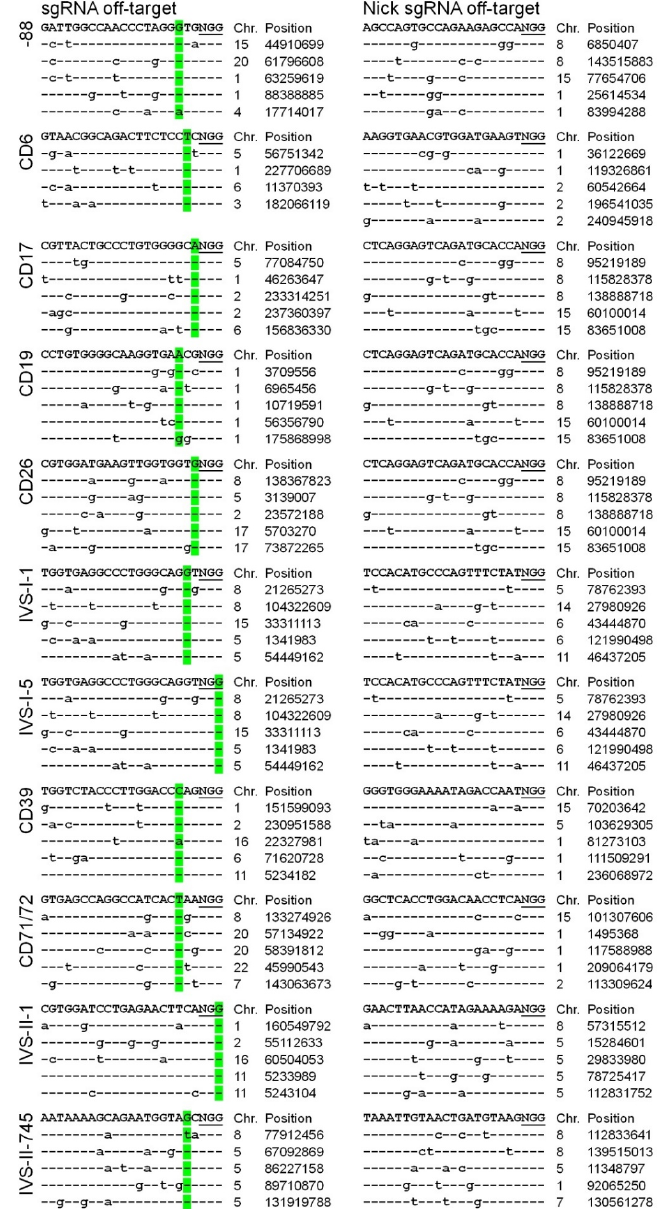
Figure 3. PE3 off-target analysis. Using the webtool Cas-OFFinder [25], off-targets were identified with at least three mismatches compared with the on-target sequences. This study selected the top five off-targets in the genome for each formula. The green fluorescence marks indicate the editing position of pegRNA, whereas the lowercase letters indicate mismatches.